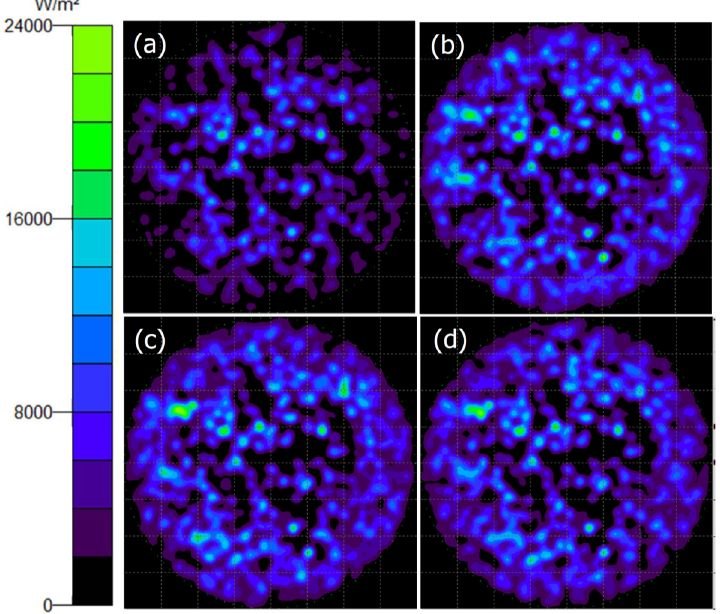
Figure 5. Simulation data of ( a ) S3.00-GaN; ( b ) S0.41-GaN; ( c ) S0.60-GaN and ( d )